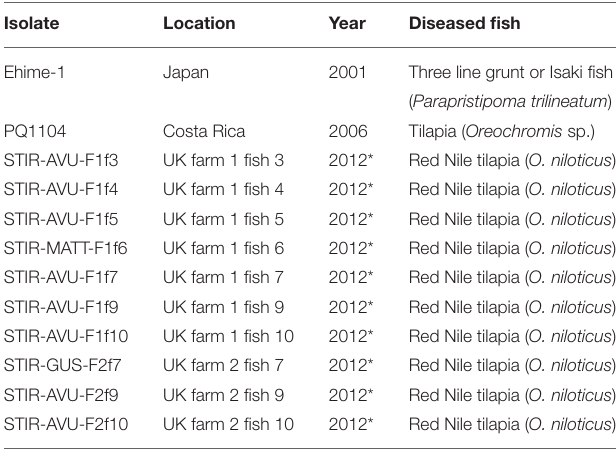
TABLE 1 | Francisella noatunensis orientalis isolates used and recovered in this